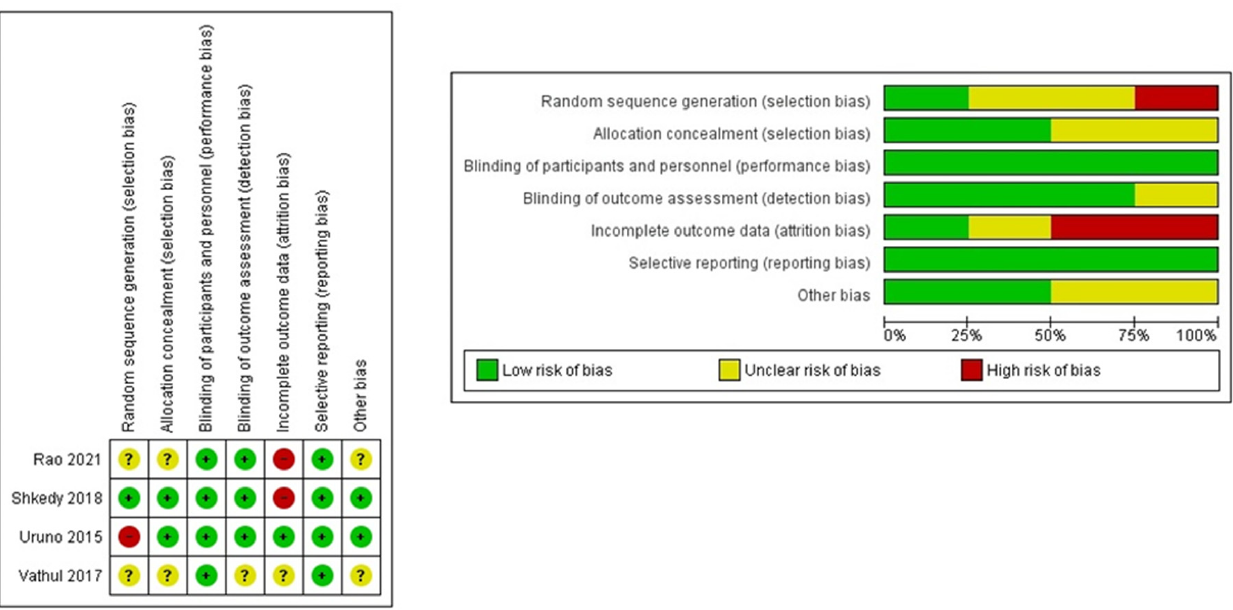
Figure 2. Risk of bias graphic and summary for the included RCTs.